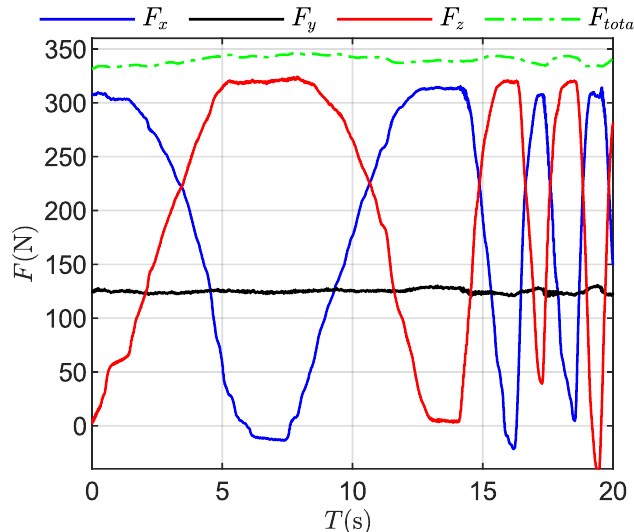
Figure 7. Force change during the rotation of the